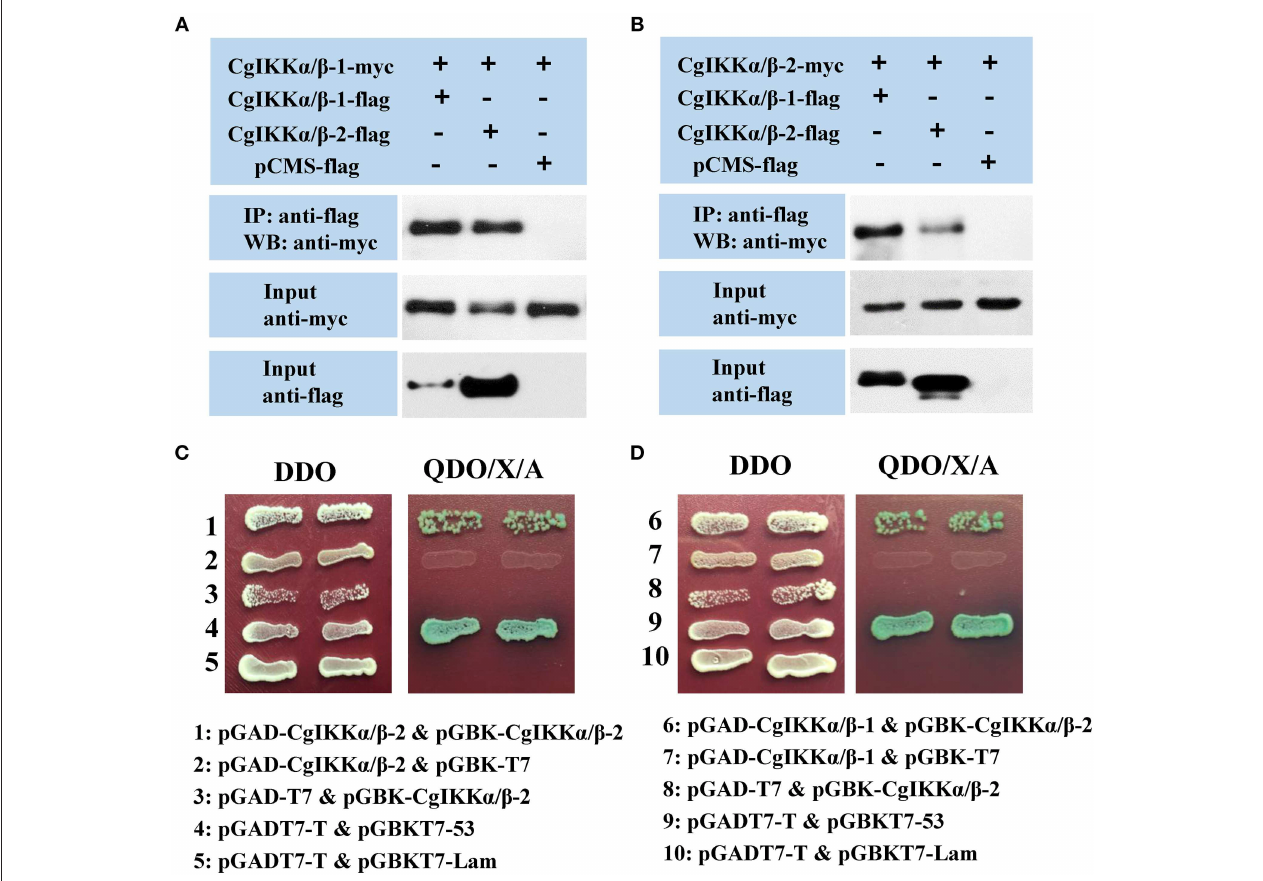
FIGURE 7 | CgIKK α / β -1 and CgIKK α / β -2 each form a homodimer and can form a heterodimer with each other. (A) Co-IP results showing that CgIKK α / β -1 and CgIKK α / β -2 interact with CgIKK α / β -1. Anti-Myc western blot bands show the expression of CgIKK α / β -1-Myc and anti-FLAG western blot bands show the expression of CgIKK α / β -1-FLAG and CgIKK α / β -2-FLAG. (B) Co-IP results showing that CgIKK α / β -1 and CgIKK α / β -2 interact with CgIKK α / β -2. Anti-Myc western blot bands show the expression of CgIKK α / β -2-Myc and anti-FLAG western blot bands show CgIKK α / β -1-FLAG and CgIKK α / β -2-FLAG. (C) Interaction between CgIKK α / β